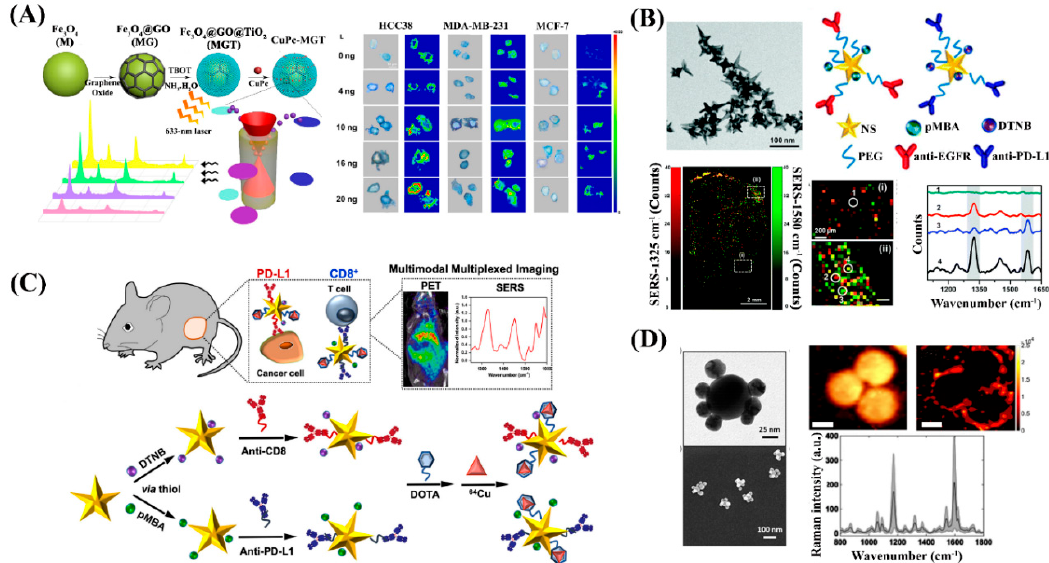
Figure 3. ( A )SynthesisandenhancementmechanismofmagneticFe 3 O 4 @GO@TiO 2 ternaryheterostructures (Left). Raman mapping images of cancer cells after different concentrations of drug treatment after 48 h (Right). Reproduced from [64], with permission from the American Association for the Advancement of Science, 2018. ( B ) Gold nanostars (AuNS) functionalized with Raman reporter molecules and antibodies for the detection of EGFR and PD-L1 (Top). Ex vivo Raman spatial maps and corresponding Raman spectra of the PD-L1 and EGFR expression using tumor tissue section (Bottom). Reproduced from [66], with permission from the Royal Society of Chemistry, 2018. ( C ) Immunoactive AuNS (IGNs) functionalized with Raman reporter molecules and anitbodies for multimodal multiplexed immunoPET-SERS imaging to detect PD-L1 + tumor cells and CD8 + T cells in tumors. Reproduced from [70], with permission from the American Chemical Society, 2020. ( D ) Au / Au core / satellite nanoparticles for immune-SERS (iSERS) microscopy of PD-L1 localization on cancer cells (Left). Fluorescence image, iSERS false-color image, and corresponding SERS spectrum (Right). Reproduced from [45], with permission from Wiley-VCH,